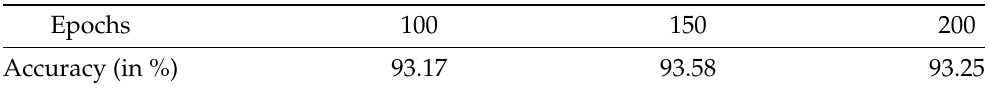
Table 8. Results obtained for different epochs keeping batch size and image size as 100 and dropout as 0.5.